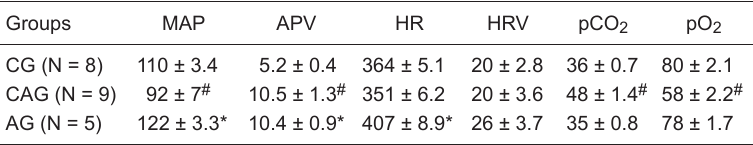
Table 1. Mean arterial pressure (MAP), arterial pressure variability (APV), heart rate (HR), heart rate variability (HRV), and pCO 2 and pO 2 concentrations in the control group (CG), carotid group (CAG) and aortic group